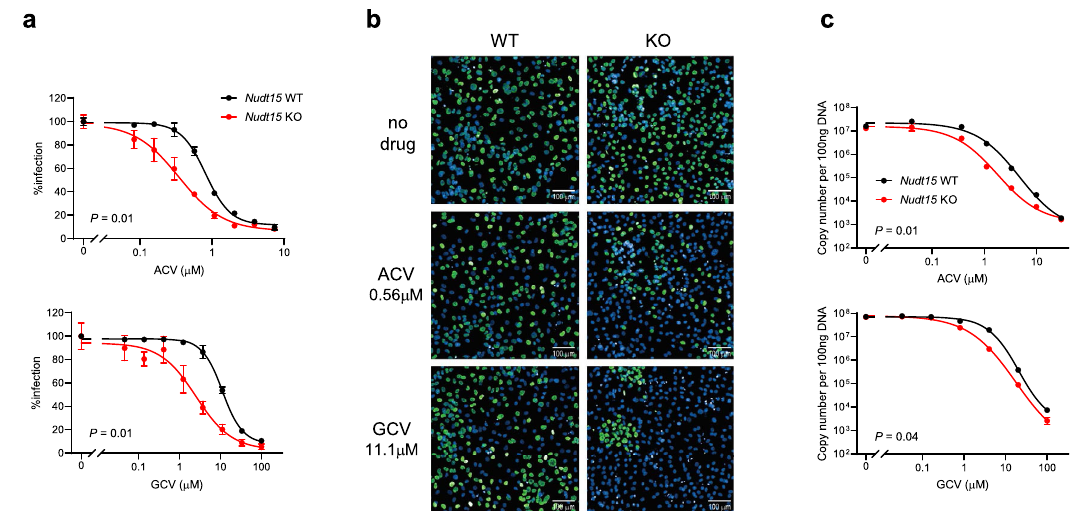
Fig. 3 Nudt15 modulates antiviral effects of acyclovir (ACV) and ganciclovir (GCV) in cytomegalovirus infection in vitro. M2-10B4 cells with Nudt15 WT or KO genotype were infected with murine CMV (MCMV) at MOI 0.01, and treated with ACV or GCV for 4 days. Viral load was evaluated by immuno fl uorescence staining of IE1 ( a ) and representative images were shown in b . c MCMV genome copy numbers per 100 ng DNA were measured by quantitative PCR. Data represent the mean of triplicates ( a ) or quadruplicate ( c ); error bars, s.d. In a and c , two-tailed paired t -test was performed to compare WT with KO. Source data for a and c are provided as a Source Data fi